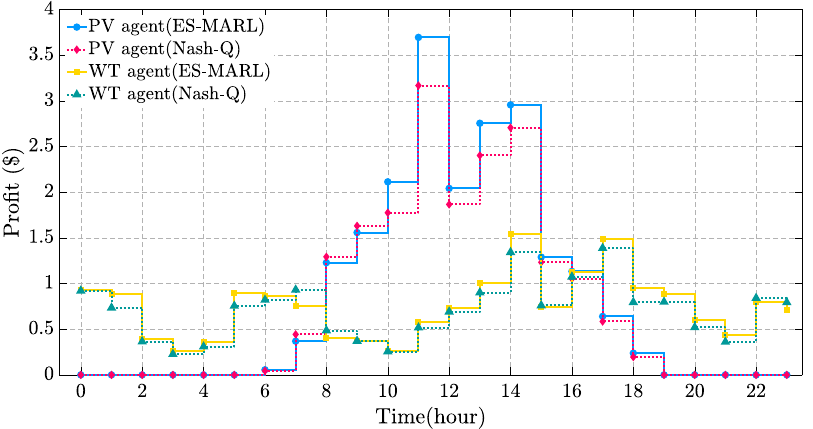
Figure 14. Profit of PV agent and WT agent with ES-MARL and Nash-Q.